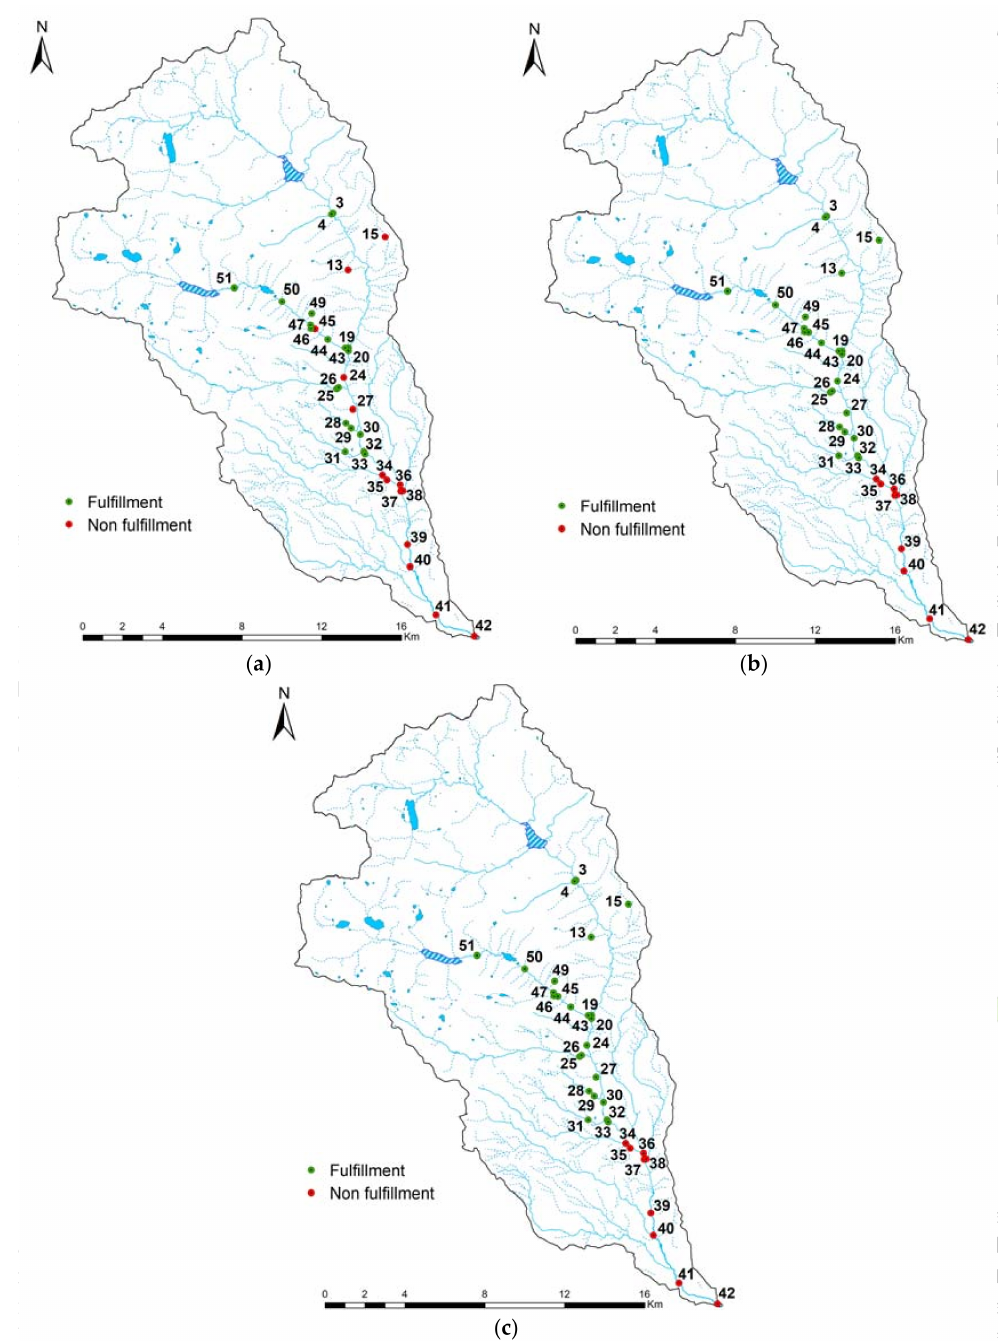
Figure 4. Fulfillment of fecal coliforms limits in relation to water use. ( a ) Recreational with primary contact; ( b ) Agricultural and livestock use; ( c ) For raw water use previous to non-conventional treatment